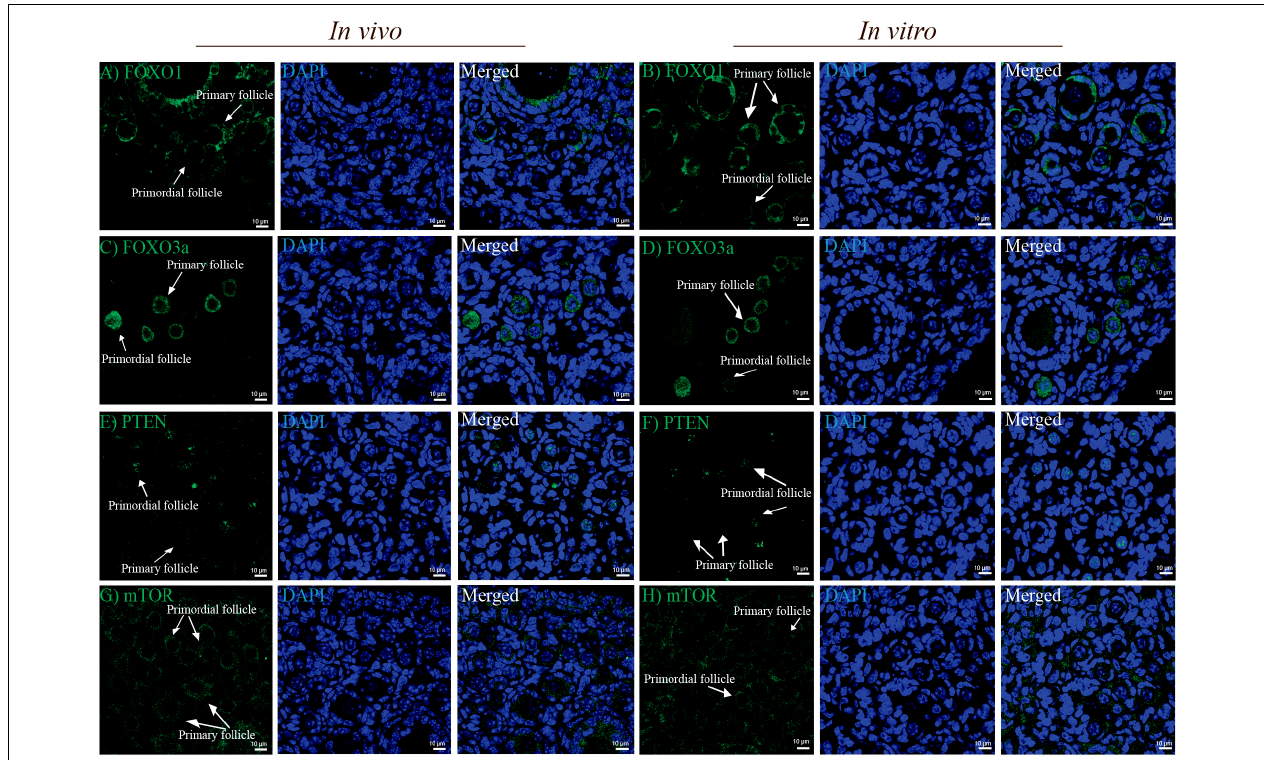
FIGURE 3 | Confocal microscopy images showing the distribution of FOXO1, FOXO3a, PTEN, and mTOR in mouse ovaries from the in vivo and in vitro groups. (A,B) FOXO1 protein was similarly localized in granulosa cells in ovaries from the in vivo and in vitro groups. (C,D) FOXO3a was distributed in the nucleus of primordial follicles and cytoplasm of primary follicles in the in vivo and in vitro groups. (E,F) PTEN was distributed more intensely in oocytes of primordial follicles than in oocytes of primary follicles in the in vivo and in vitro groups. Notably, PTEN in oocytes of primary follicles was undetectable. (G,H) mTOR was equally distributed in oocytes of primordial and primary follicles from both the in vivo and in vitro groups. DAPI staining shows the cell nuclei. Scale bar: 10 µ m.